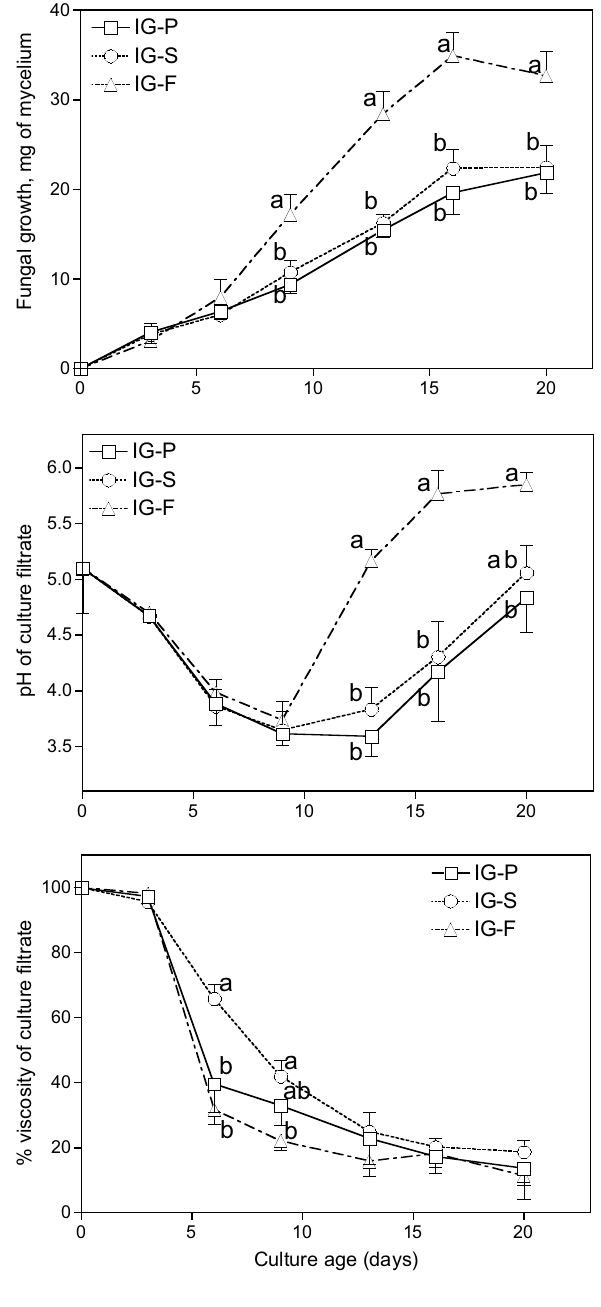
Fig 1. Time-course determination of fungal growth, pH and viscosity of the culture filtrate of the intersterile groups (IGs) P (- (cid:1) -), S (- (cid:2) -) and F (- (cid:1) -) of Heterobasidi- on annosum grown in liquid nutrient medium supple- mented with 1% pectin as the sole carbon source. Values are means of 9 isolates of IG-P and IG-S and 8 isolates of IG-F; bars represent SE. Means followed by the same let- ter at each incubation time do not significantly differ at P =0.05, according to Tukey’s test; absence of letters indi- cates no significant differences among the IGs. Fungal growth is expressed as mg of dry weight biomass. Viscos- ity of culture filtrate is expressed as the percentage of sample viscosity as compared with the uninoculated con- trol